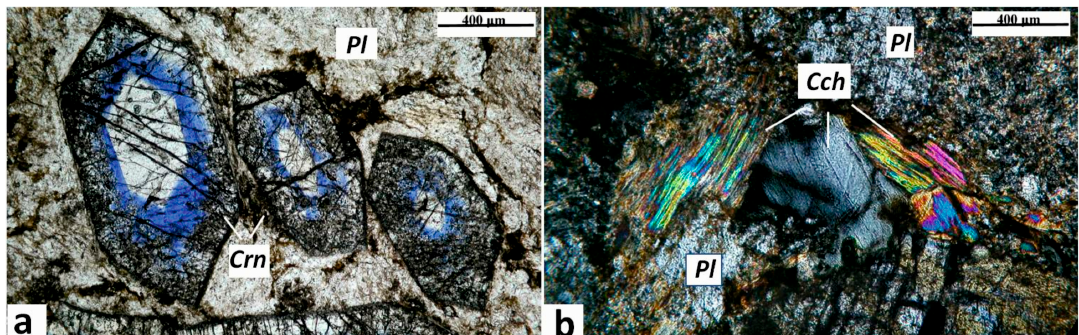
Figure 4. Photomicrographs of corundum-blue sapphire anorthosite-kyshtymite samples 8-K: ( a ) idiomorphic crystals of corundum-sapphire (Crn) with oscillatory white-blue zonation within the matrix of fine-grained plagioclase (Pl), parallel polarized light. The dotted arrows show the profiles measured by LA-ICP-MS (cf. Table 1). ( b ) Xenomorphic crystals of clinochlore (Cch) associated with plagioclase, crossed polarized light.